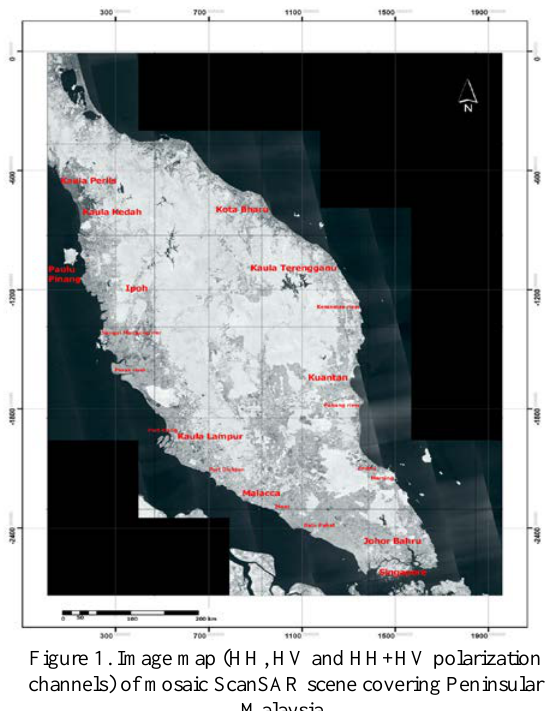
Figure 1. Image map (HH, HV and HH+HV polarization channels) of mosaic ScanSAR scene covering Peninsular